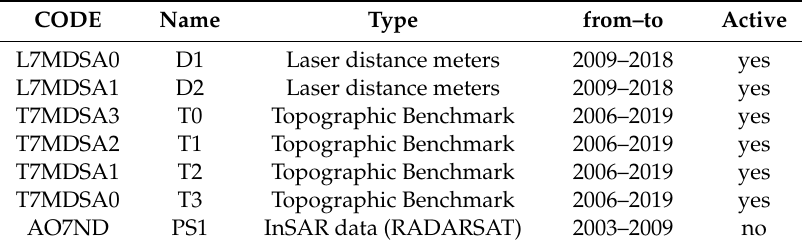
Table 1. List of ARPA Piemonte monitoring data used for this